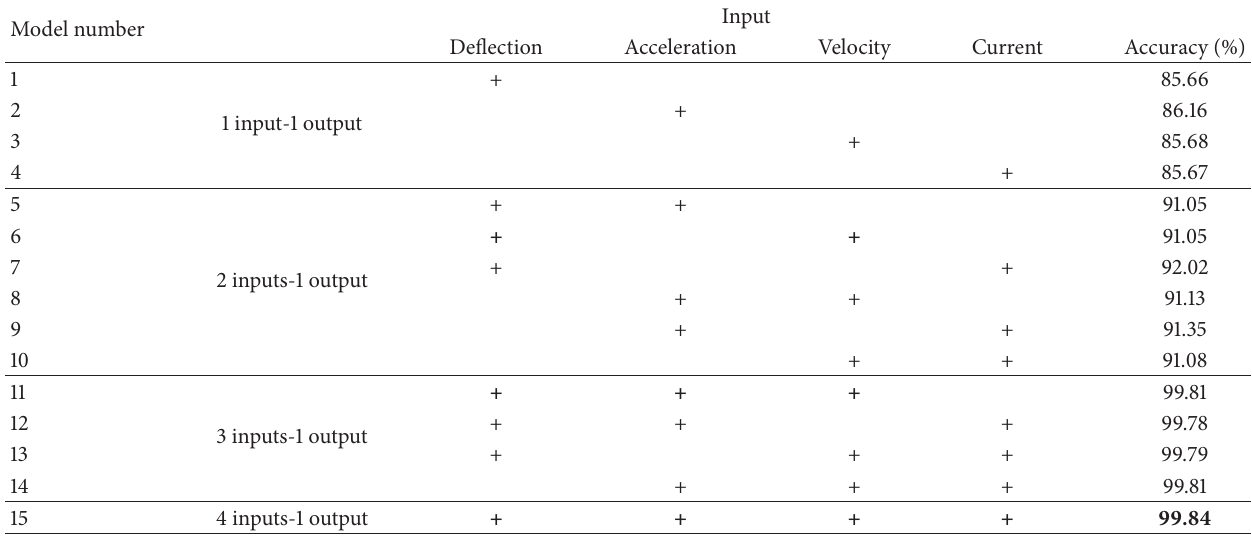
Table 6: Simulation parameter studies for the OF neurofuzzy